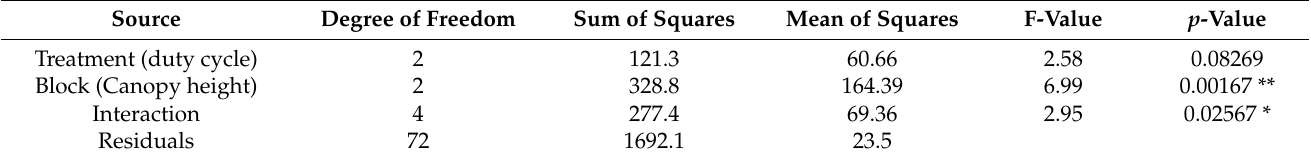
Table 3. ANOVA analysis for droplet deposition (* p ≤ 0.05, ** p ≤ 0.01)